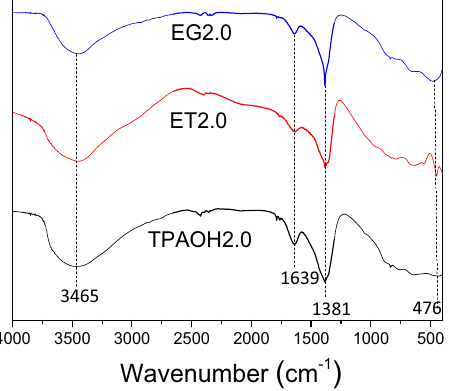
Figure 3: The FT - IR spectrum of EG2.0, ET2.0, and TPAOH2.0.